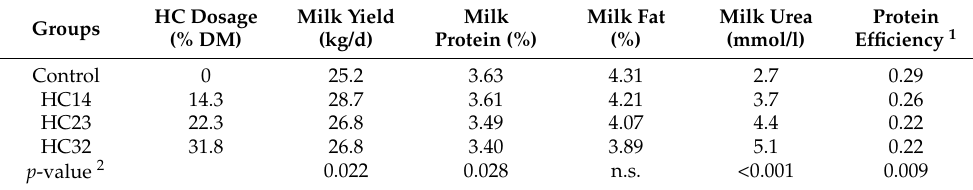
Table 4. Effect of hempseed cake (HC) on milk yield and composition [33].